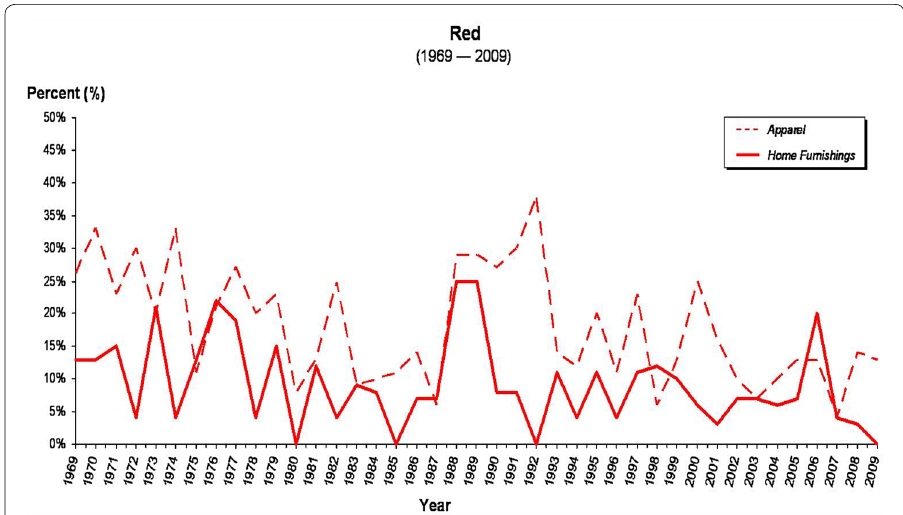
Fig. 3 Red: incidences of red in home furnishings and apparel